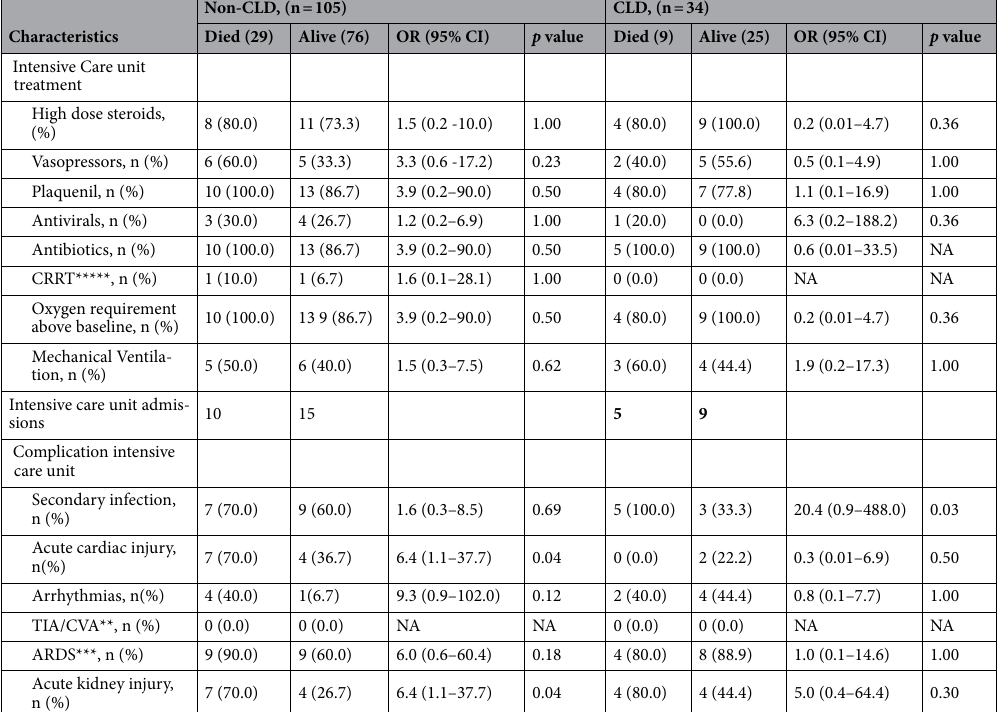
Table 5. Predictors of mortality in patients with or without history of CLD. MCCI*, Modified Charlson Comorbidity Index (liver disease not included in calculation of score); TIA/CVA**, transient ischemic attack/cerebrovascular accident; COPD***, chronic obstructive pulmonary disease; HIV/AIDS****, human immunodeficiency virus/acquired immunodeficiency syndrome; CRRT *****, continuous renal replacement